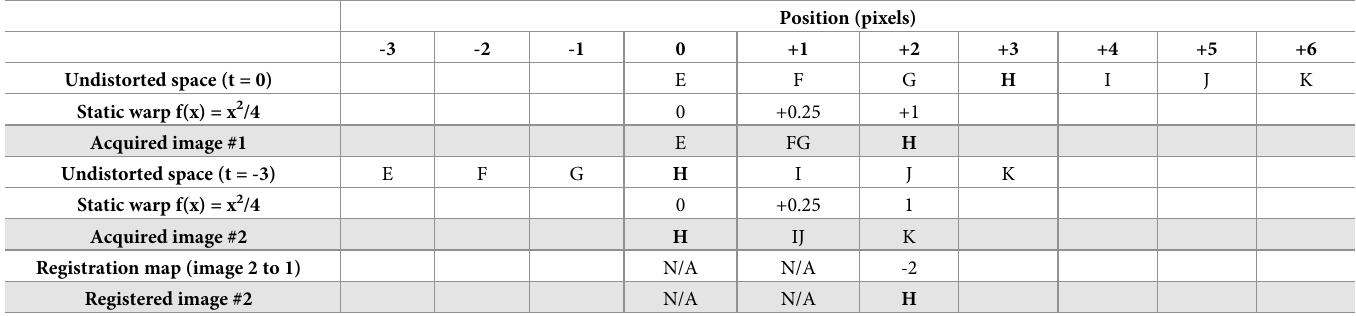
Table 1. Simplified example in